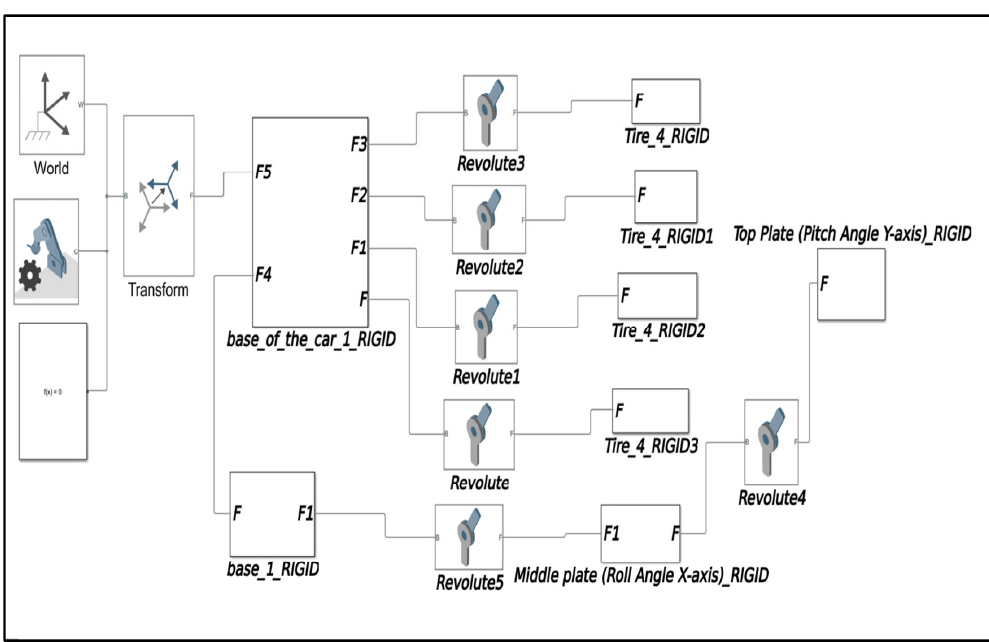
Fig. 8. The Simscape model of the self-balancing platform on the mobile